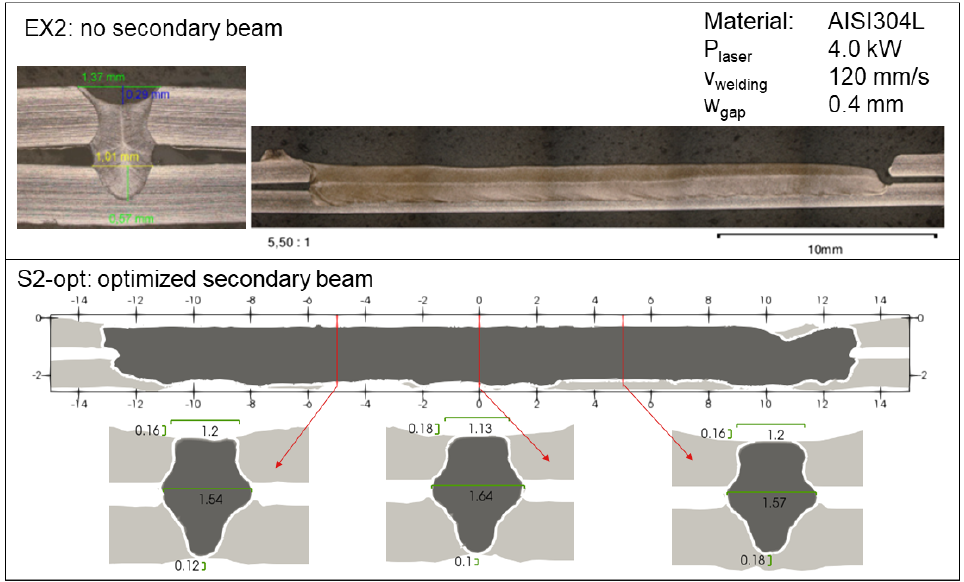
Figure 9. Results of simulation S2-opt, where a secondary laser beam was added to the conditions of EX2 and iteratively optimized. All measurements in (mm).